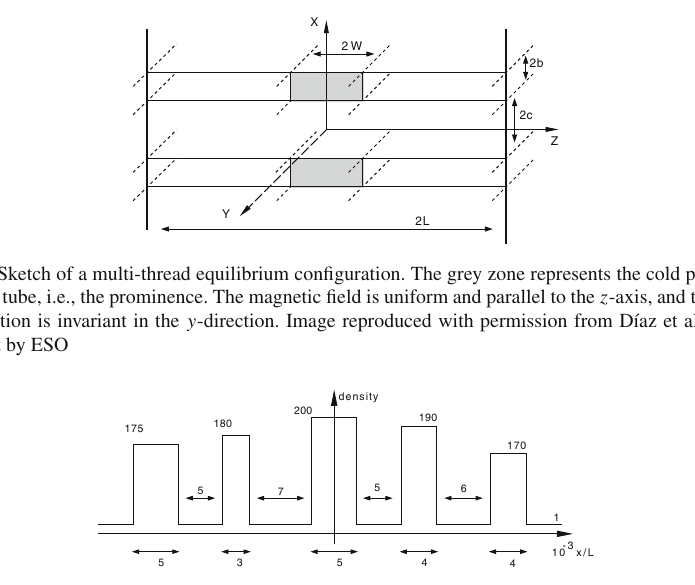
Fig.54 Sketchofthedensityprofileinthedirection z = 0ofaninhomogeneousmulti-threadsystem,where the density values are normalised to the coronal value. Between and under the threads the dimensionless separation, 2 c / L , and “diameter”, 2 b / L , are given. Image reproduced with permission from Díaz et al. (2005), copyright by